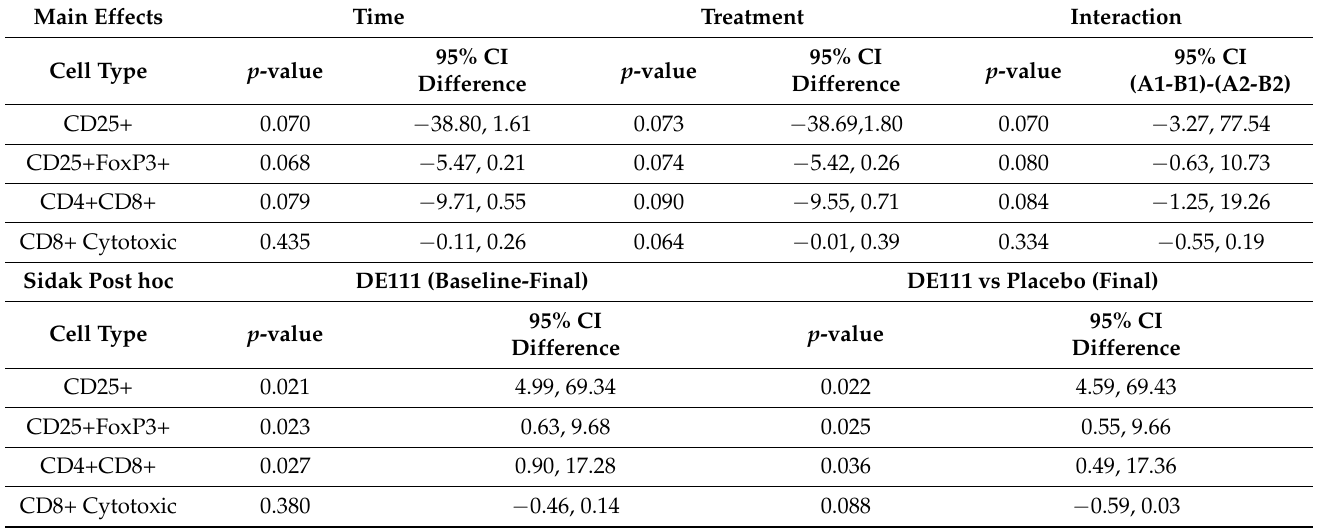
Table 3. Statistical analysis (Mixed-Effects Model with Sidak post hoc comparisons) for LPS-induced response ratios of significant and trending changes in immune cell